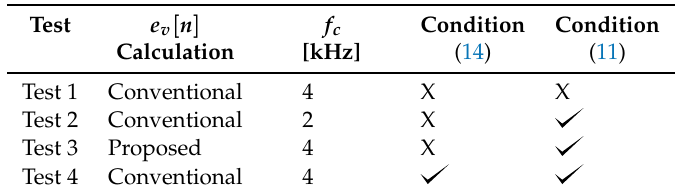
Table 4. Summary of the